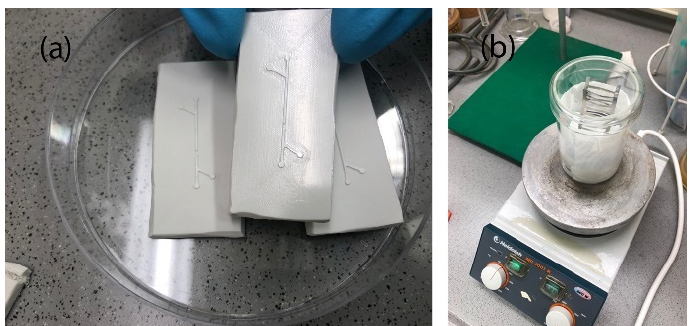
Figure 23. Acetone polishing of ABS casting molds fabricated by milling. ( a ) ABS casting mold exposed to acetone vapor for 30 s. ( b ) Setup for acetone vapor polishing.